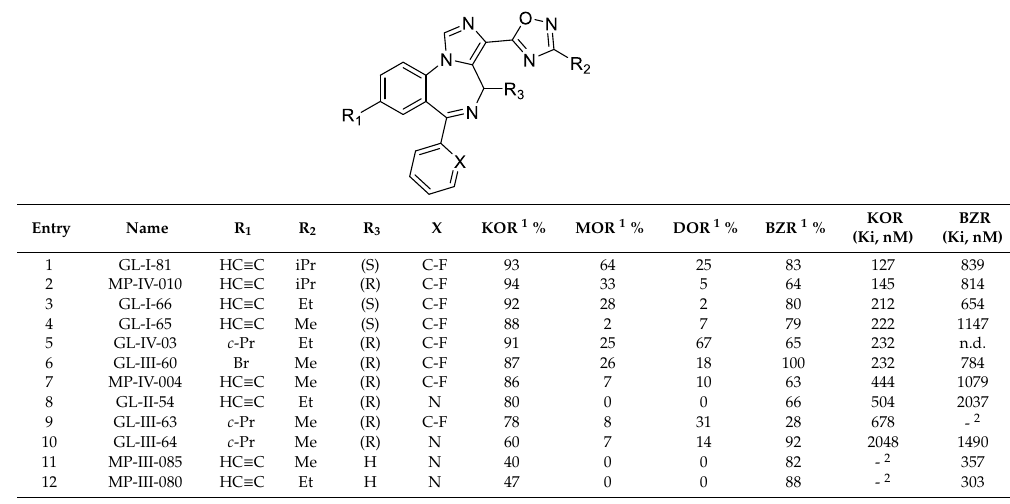
Table 3. Opioid and benzodiazepine receptor binding of imidazodiazepine oxadiazoles.